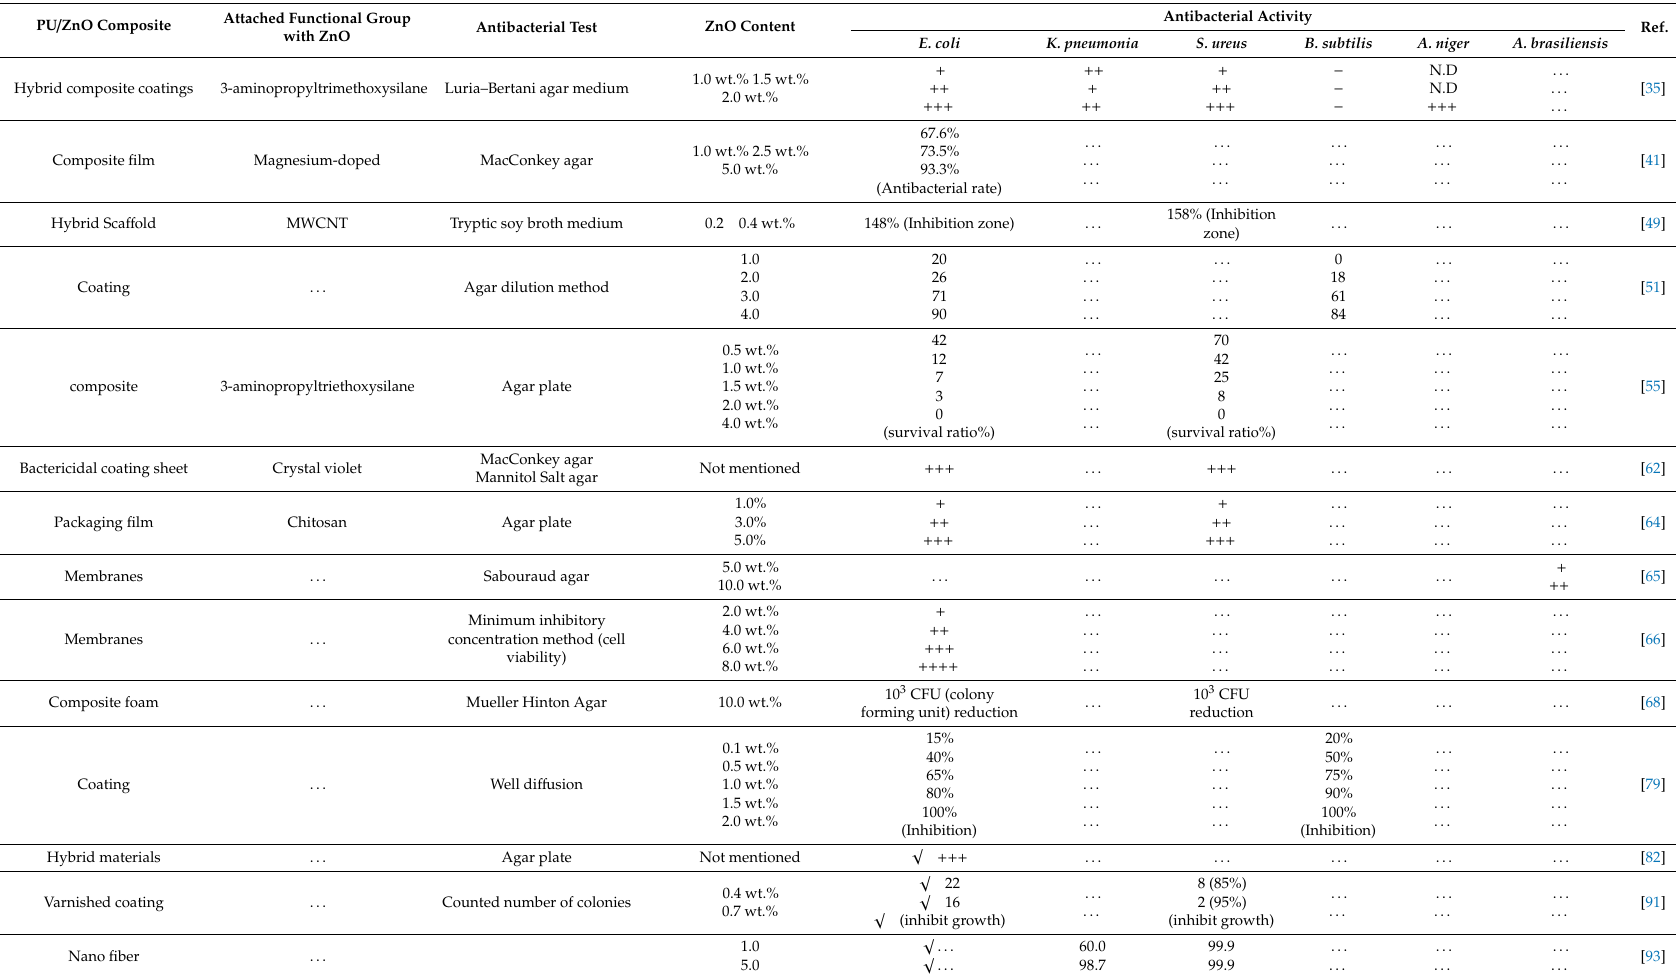
Table 6. Antibacterial properties of PU / ZnO